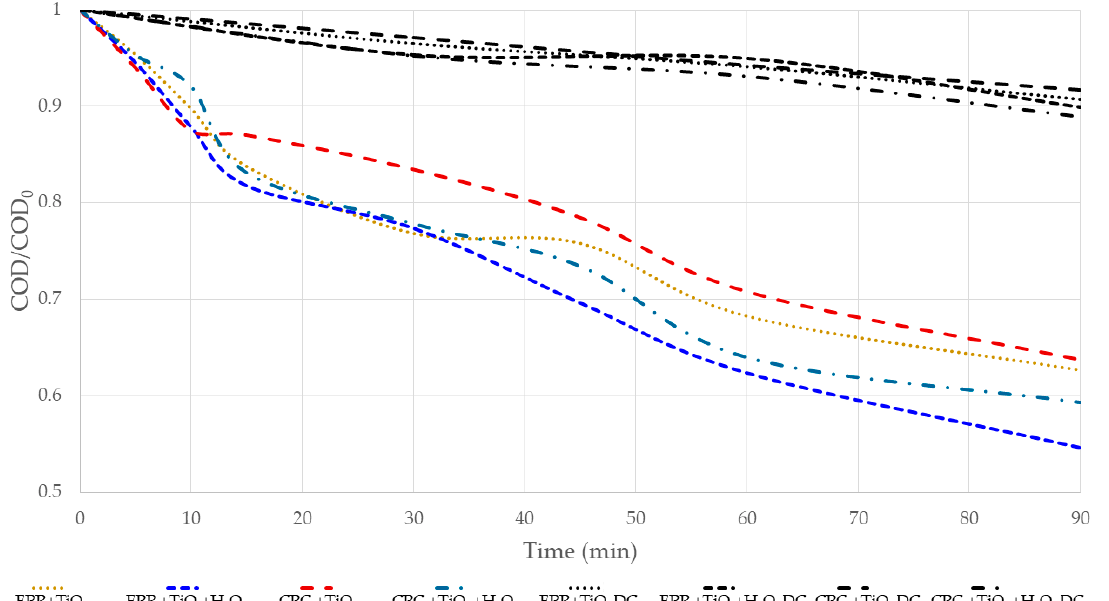
Figure 2. Chemical-oxygen-demand decrease in heterogeneous photocatalytic degradation for both flat-plate reactor (FPR), with (FPR + TiO 2 + H 2 O 2 ) and without (FPR + TiO 2 ) H 2 O 2 addition, and compound parabolic collector reactor (CPC), with (CPC + TiO 2 + H 2 O 2 ) and without (CPC + TiO 2 ) H 2 O 2 addition. Control experiments performed in the dark (DC) are also included for both flat-plate reactor (FPR), with (FPR + TiO 2 + H 2 O 2 DC) and without (FPR + TiO 2 DC) H 2 O 2 addition, and compound parabolic collector reactor (CPC), with (CPC + TiO 2 + H 2 O 2 DC) and without (CPC + TiO 2 DC) H 2 O 2 addition.